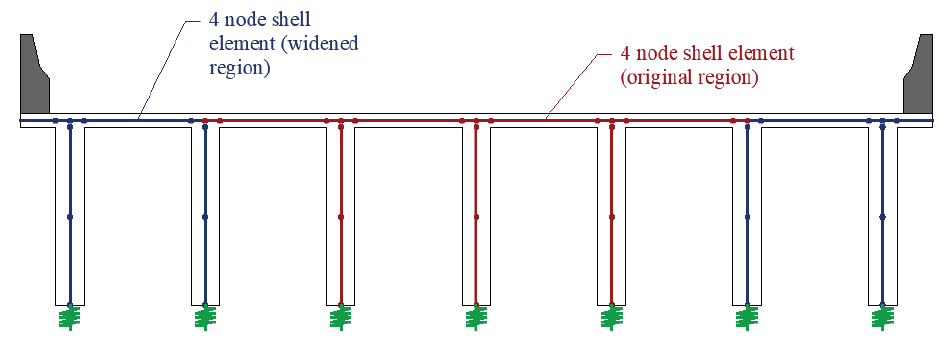
Figure 7. Discretization of bridge cross section in numerical model.